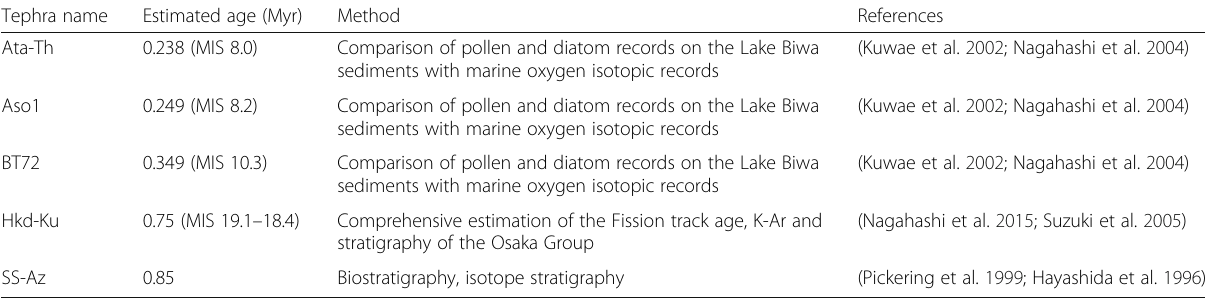
Table 3 Tephra ages used as time references for δ 18 O isotope stratigraphy. The estimated age, method of age determination, and references are given for each tephra